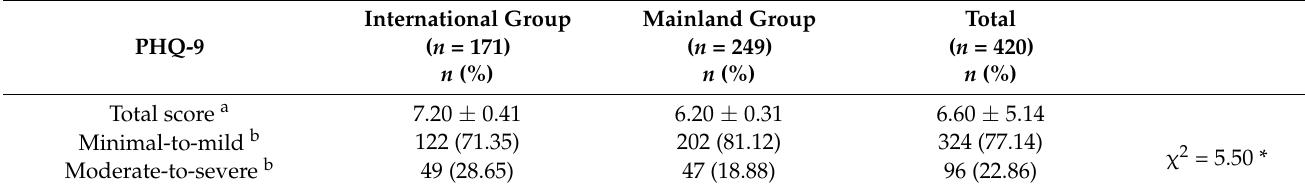
Table 4. Difference in depressive symptoms between the students in Mainland China and South Korea.